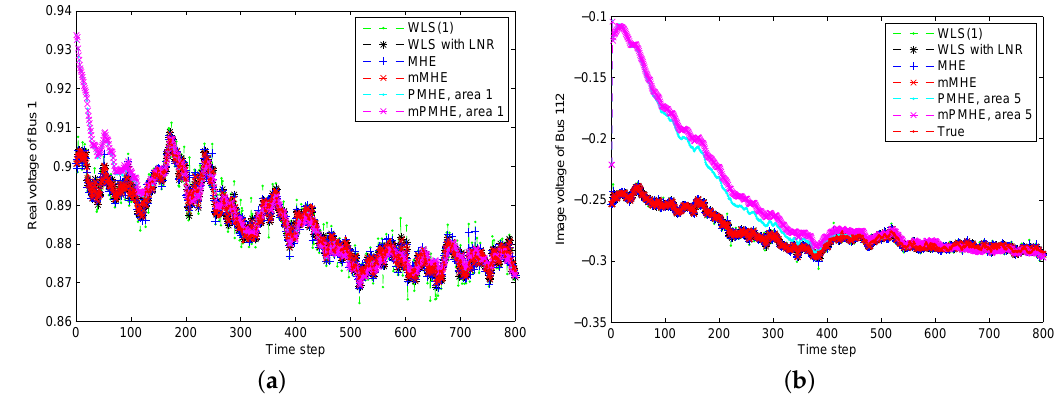
Figure 13. The estimated results of different estimators under non-Gaussian noise assumption. “WLS(1)” represents the results when the WLS estimator uses the measurements with horizon length 1. ( a ) The real part of Bus 1 voltage phasor. ( b ) The imaginary part of Bus 112 voltage